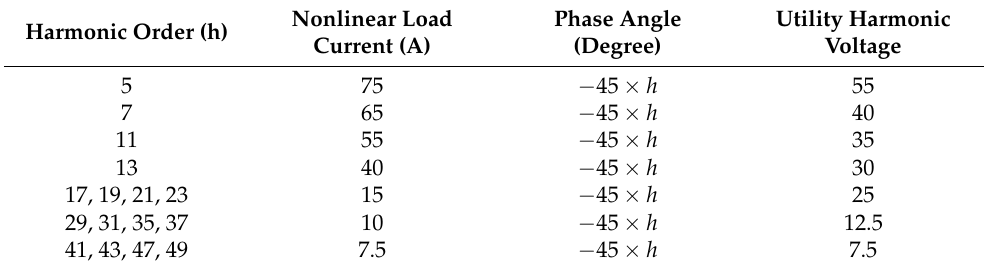
Table 2. The nonlinear loads and utility side’s background harmonic voltage.